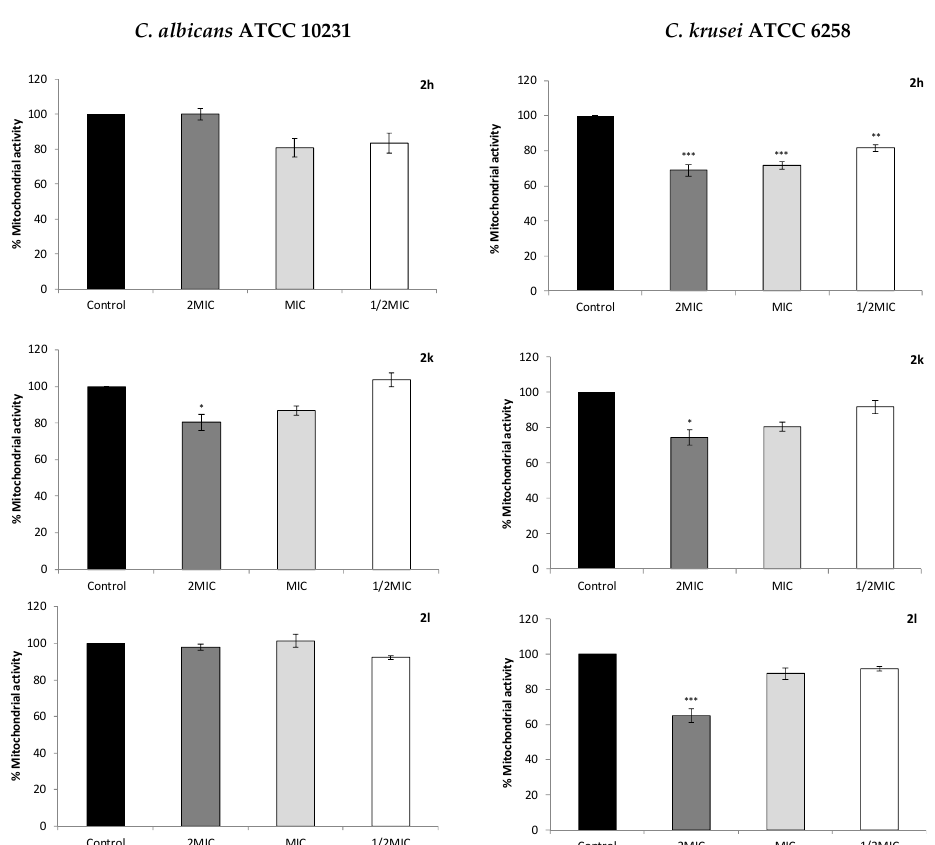
Figure 2. Mitochondrial activity of Candida albicans ATCC 10231 and Candida krusei ATCC 6258 cells treated with different concentrations of 5-aminoimidazole-4-carbohydrazonamide derivatives. Results are expressed as the means ± standard error of the mean (SEM) of three independent experiments. Controls included 1% of DMSO. MIC, minimal inhibitory concentration. * p < 0.05; ** p < 0.01; *** p < 0.001 (one-way ANOVA followed by Dunnett’s test). Antibiotics 2021 , 10 , x FOR PEER REVIEW